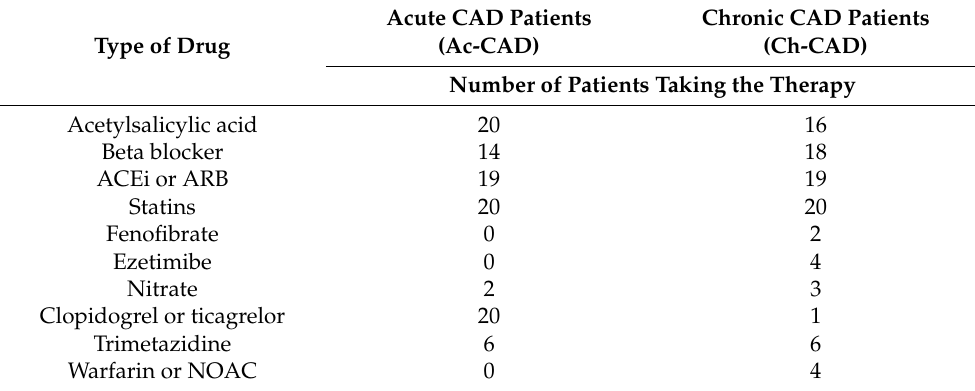
Table 1. Existing drug treatment used in the study population: patients with existing coronary artery disease